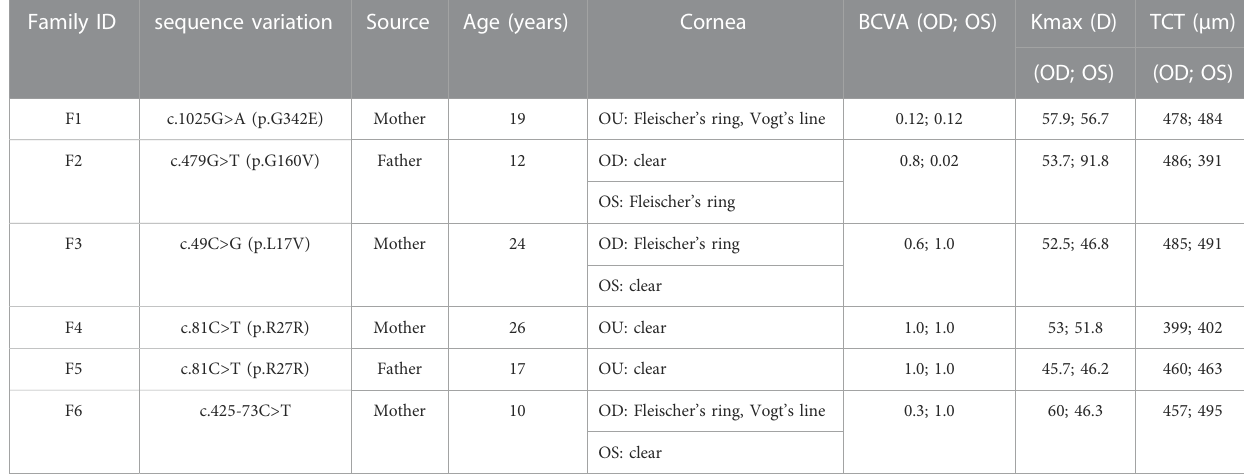
TABLE 2 The general clinical data of the probands in the six families with VSX1 sequence variations. Family